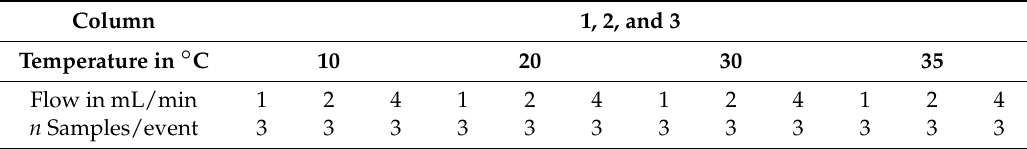
Table 1. The experimental design of the column